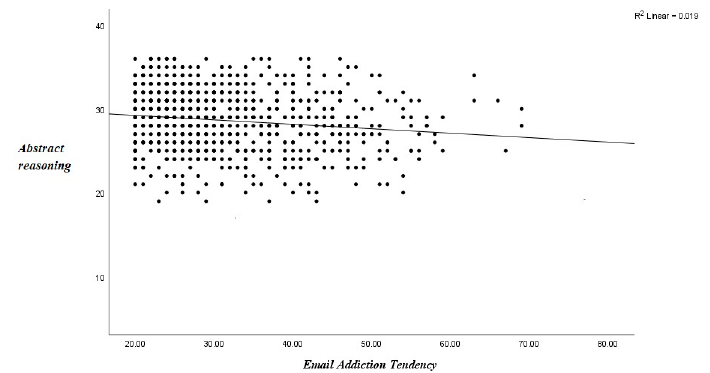
Figure 3. Associations between email dependence and abstract reasoning.